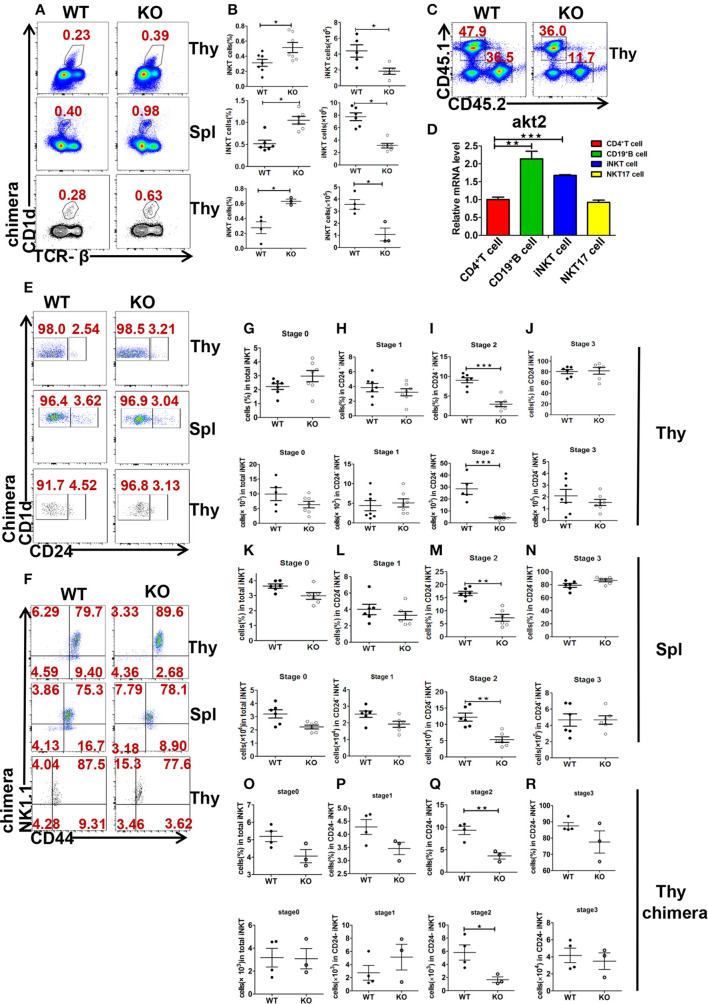
Akt2 deficiency reduces the accumulation of stage 2 iNKT cells. (A) Flow cytometry of iNKT cells (CD1d-PBS57+TCRβ+) in the thymus (Thy) and spleen (Spl) from WT, KO, and chimera mice. (B) Percentages and absolute numbers of iNKT cells in the thymus and spleen from WT (n = 7), KO (n = 6), WT chimera mice (n = 4) and Akt2 KO chimera mice (n = 3). (C) CD45.1 and CD45.2 staining in thymus of chimera mice. (D) mRNA levels of akt2 gene in CD4+T cells, CD19+B cells, iNKT cells, and NKT17 cells of WT mice. Expression of indicated mRNA from FACS-sorted CD4+T cells, CD19+B cells, iNKT cells and NKT17 cells of WT mice. (E,F) Thymic and splenic iNKT cell development stages. Percentages (G–J, upper panel) and absolute numbers (G–J, lower panel) of stages 0–3 iNKT cells from WT (n = 7) and KO mice (n = 7) in the thymus. Percentages (K–N, upper panel) and absolute numbers (K–N, lower panel) of stage 0–3 iNKT cells from WT (n = 6) and KO mice (n = 6) in the spleen. (O–R, upper panel) percentages and absolute numbers (O–R, lower panel) of stage 0–3 iNKT cells from WT chimera mice (n = 4) and Akt2 KO chimera mice (n = 3). *p < 0.05; **p < 0.01; ***p < 0.001 determined by the Student's t-test.